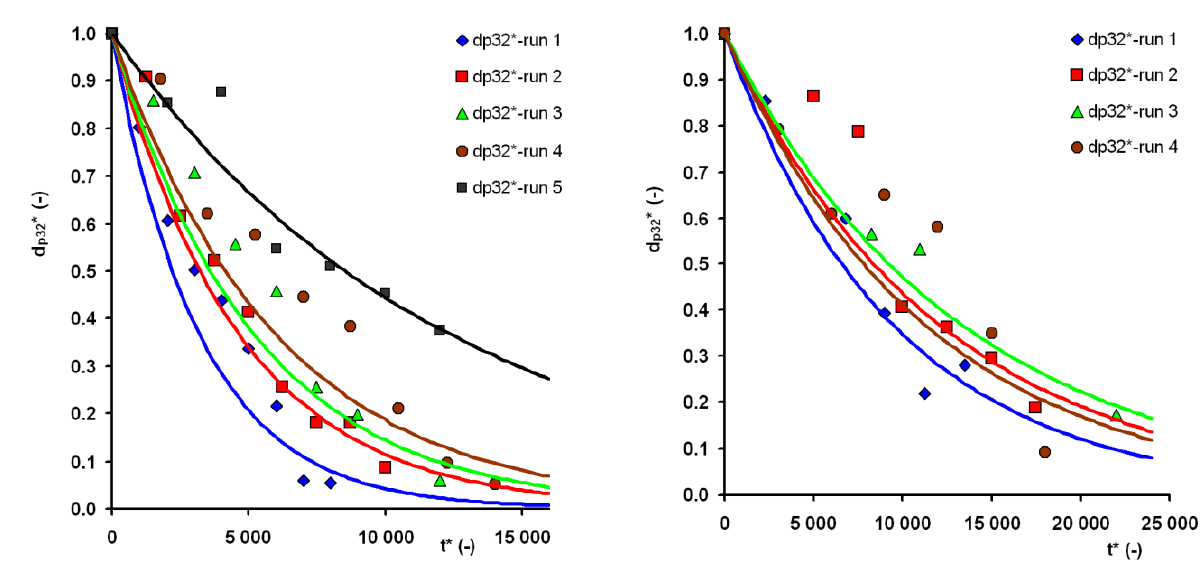
Fig. 6. Time evolution of dimensionless d p32 – Rushton turbine